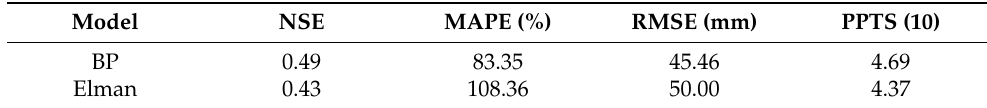
Figure 6. Forecasted and observed monthly streamflow during the validation period by the BP and Elman models. Table 2. Evaluation of monthly runoff predictions by two standard AI models. Table 2. Evaluation of monthly runoff predictions by two standard AI